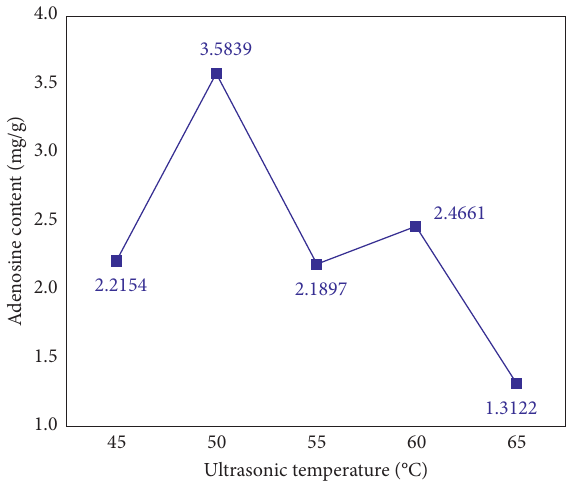
Figure 7: Effect of ultrasonic temperature on the adenosine content.